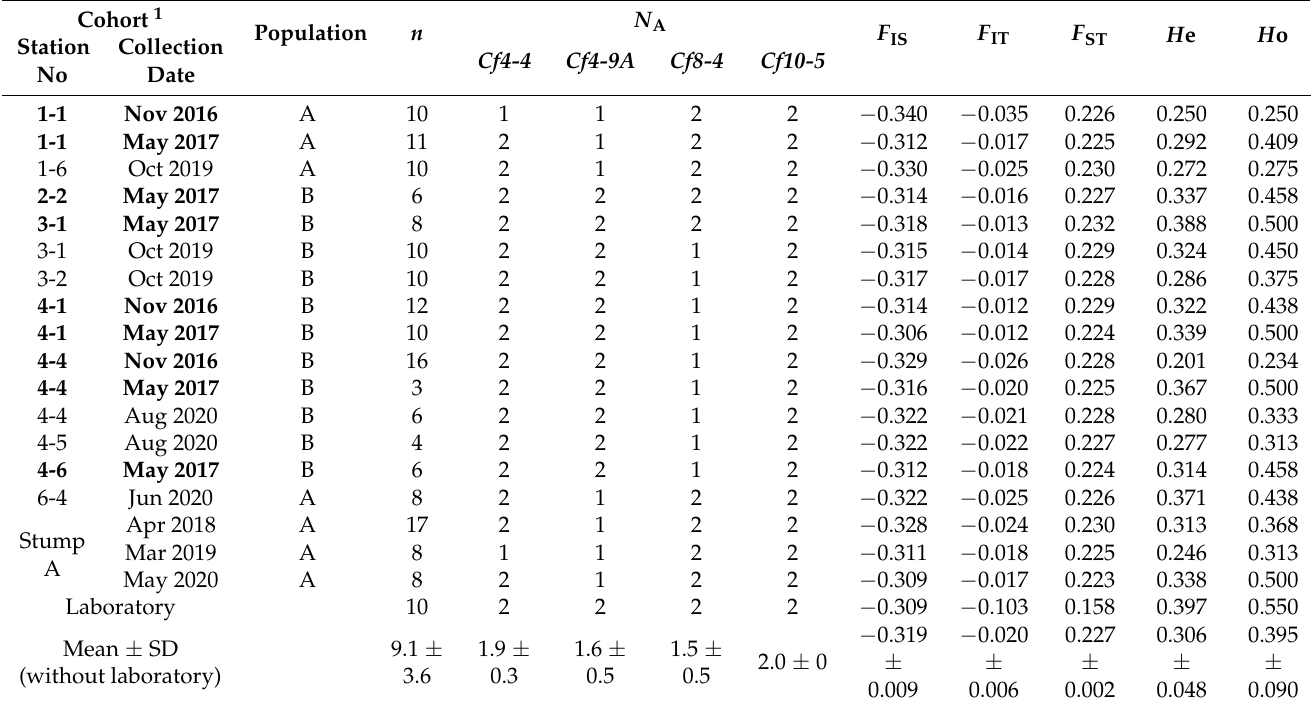
Table 1. Statistics of microsatellite loci and F -statistics for Coptotermes formosanus cohorts collected in Isogi Park from